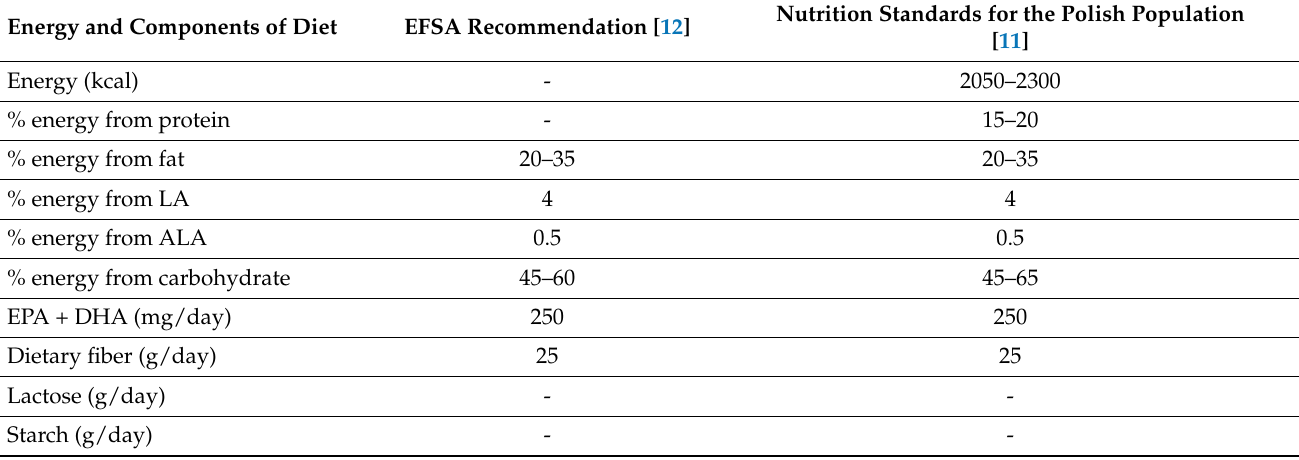
Table 2. Dietary reference values of nutrients for young women aged 19–30 years